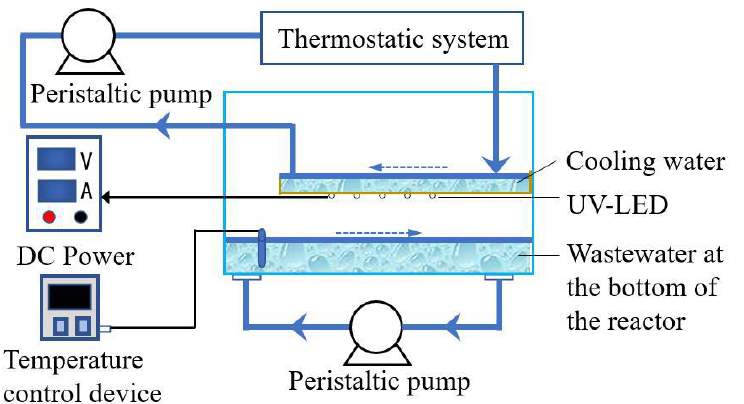
Figure 1. Schematic diagram of a degradation system that circulates cooling water and wastewater separately.